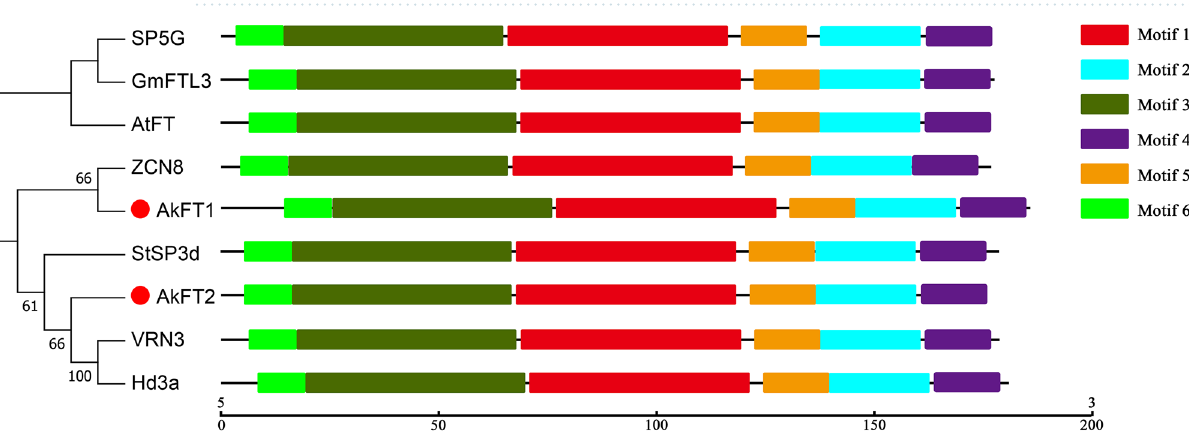
Figure 4. Phylogenetic analysis of FT proteins. Phylogenetic tree of FT homologous proteins using the neighbor-joining method by MEGA 7 (Bootstrap: 1000 replicates). Conservative motif analysis of FT homologous proteins using MEME. The proteins are as follows: A. thaliana AtFT , AAF03936.1; Rice Hd3a , BAO03048.1; Wheat VRN3 , ABK32208.1; Glycine max GmFTL3 , ACA24487.1; Maize ZCN8 , NP_001106247.1; Tomato SP5G , NP_001307981.1; Potato StSP3d ,